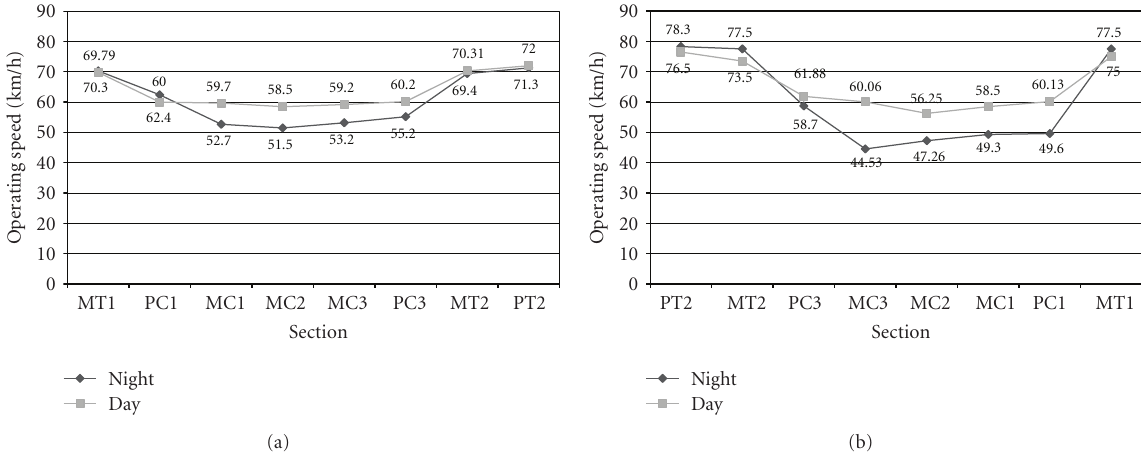
Figure 8: Night/day operating speed (S 85 , km/h), eastwards (a) and westwards (b), in real environment.